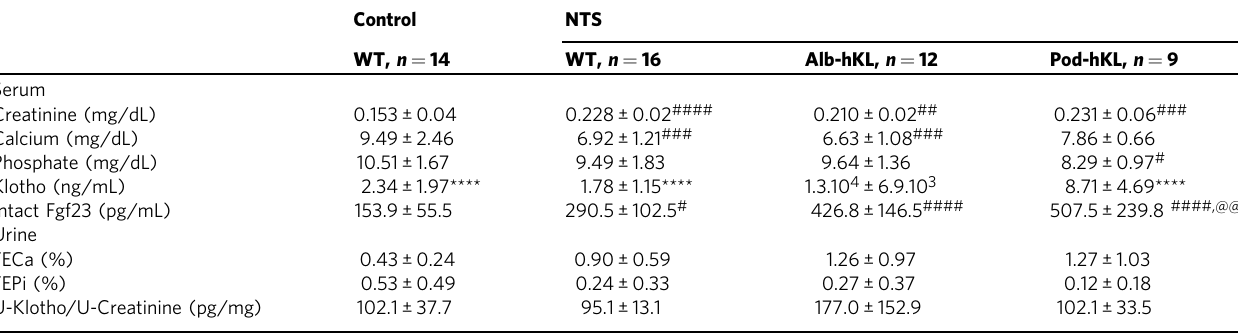
Table 2 Serum and urinary biochemistry in WT, Alb-hKL, and Pod-hKL mice 7 days after NTS injection compared to